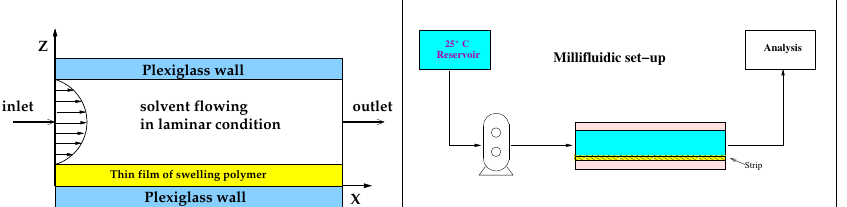
Figure 1. Millifluidic flow-through device. Schematic representation of the experimental